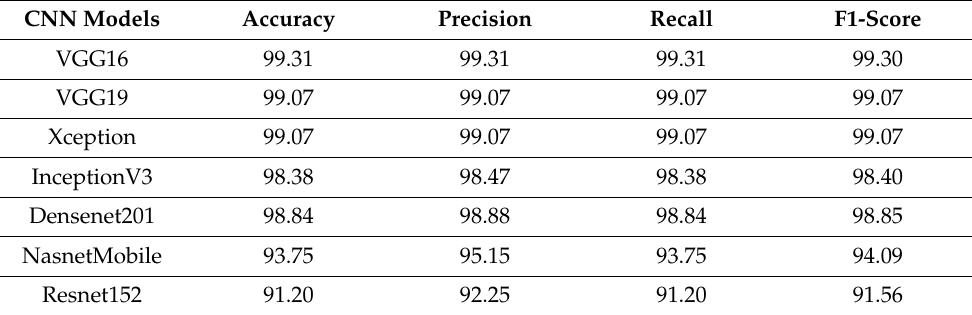
Table 5. Weighted average of performance metrics by different deep learning models for COVID-19 and tuberculosis classification.